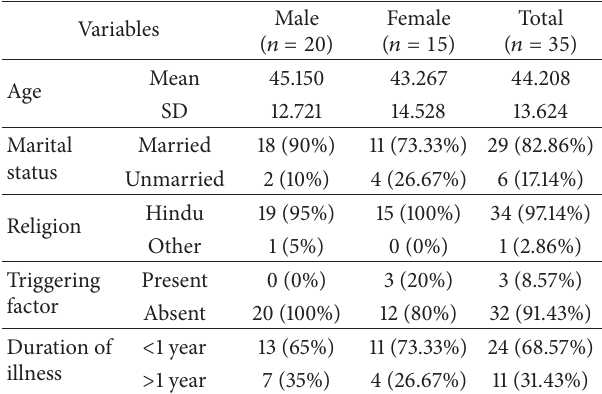
Table 1: Sociodemographic